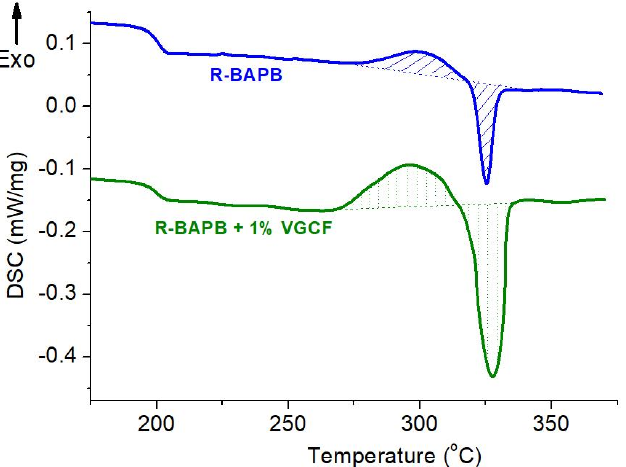
Figure 9. DSC thermograms of the unoriented (DR = 1) amorphous fibers of polyimide R-BAPB with the VGCF nanofillers.